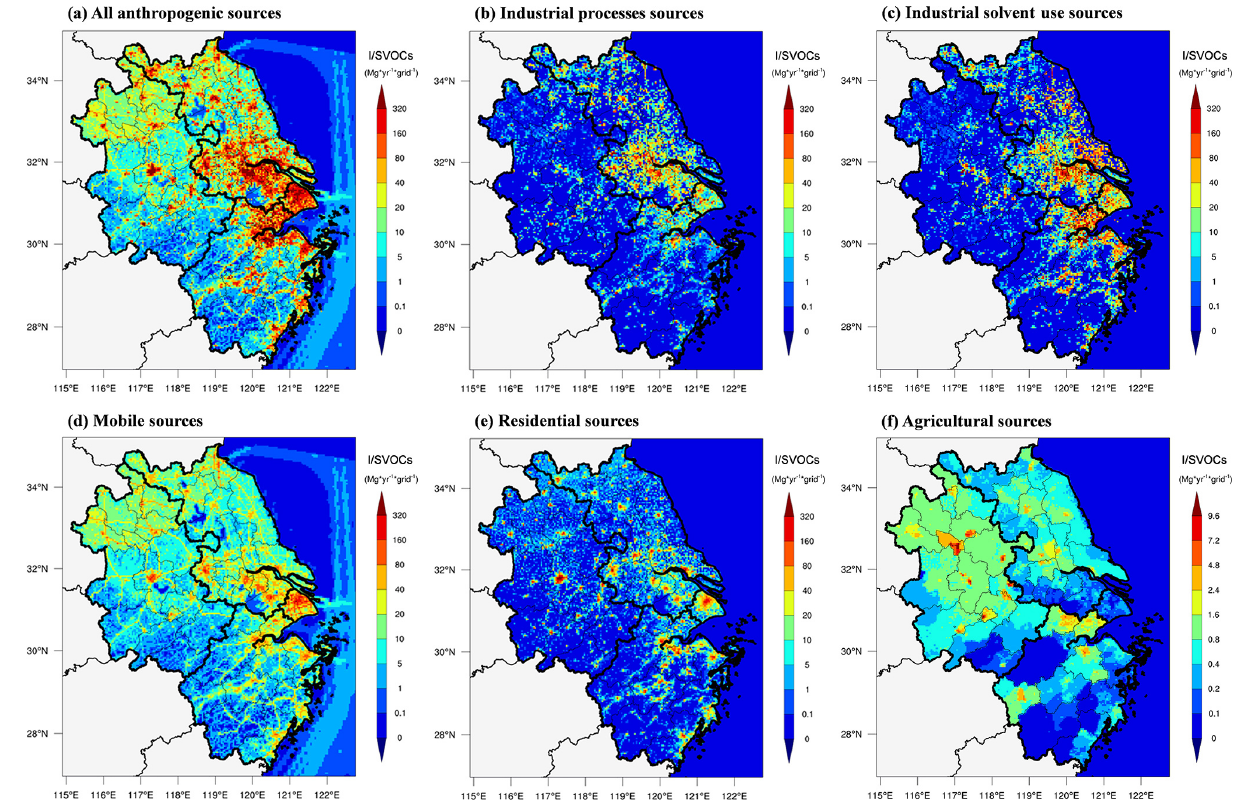
Figure 4. Spatial distributions of I/SVOC emissions from different source categories in the YRD region for the year 2017.